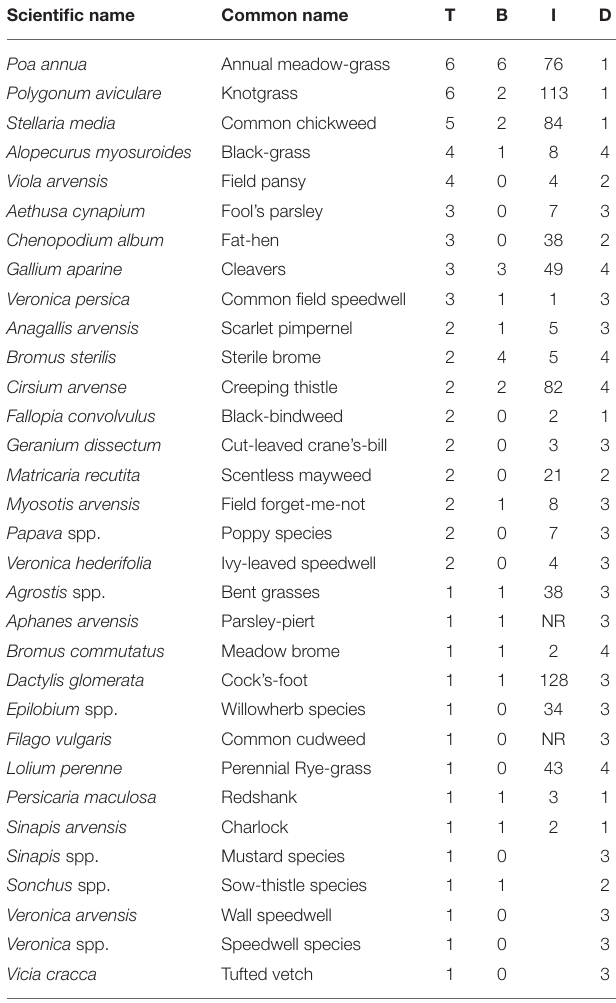
TABLE 3 | Mean percentage cover of broadleaves and grasses in the seven studies.